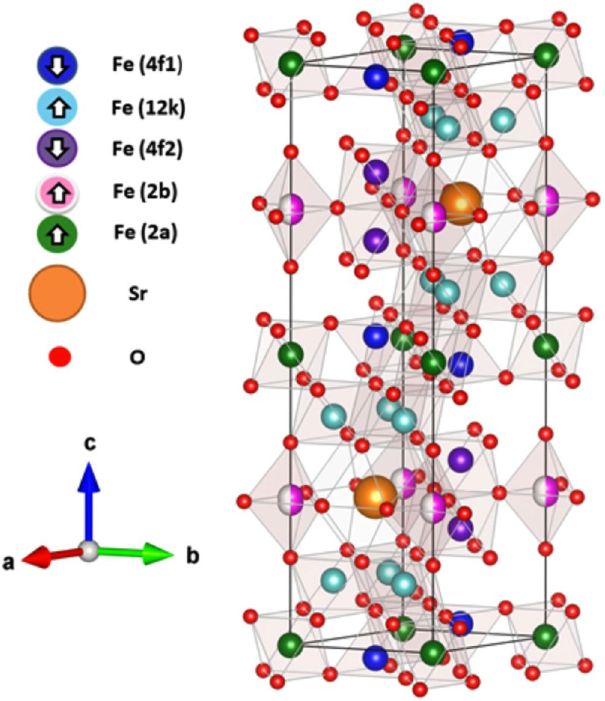
Figure 1. Crystallographic structure of (SrFe 12 O 19 ) 2 . This figure was made through TESTA program 63